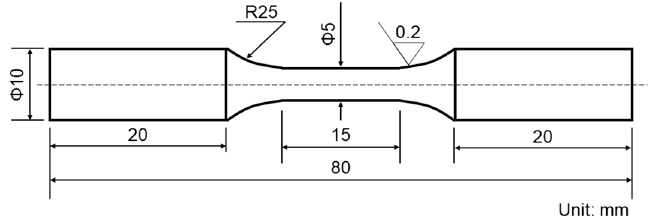
Figure 3. Dimensions of low-cycle fatigue samples.